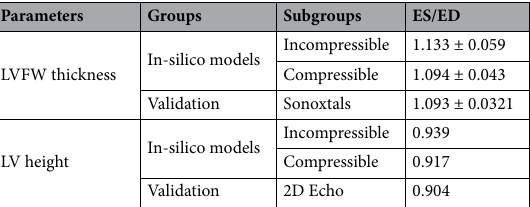
Table 1. Comparisons of wall thickness change of LV free wall and shortening of LV height between in-silico models and validation data.